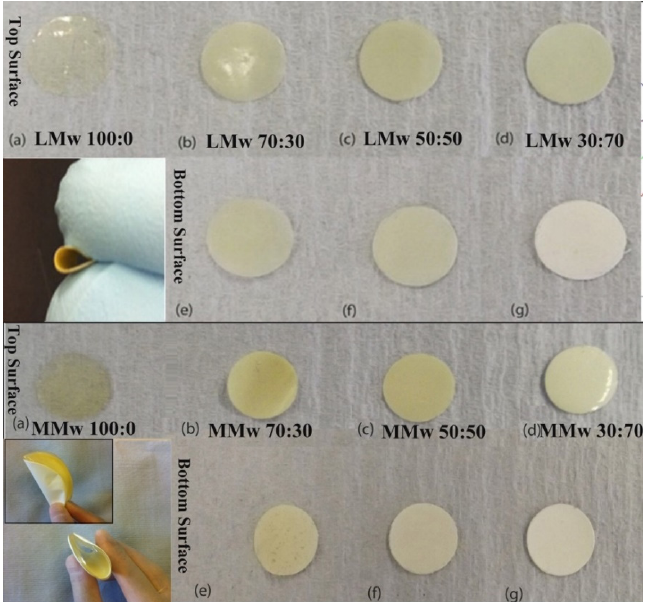
Figure 1. Optical images of LMw and MMwCH:HA membranes in different ratios of CH to HA with clear distinction between top and bottom surfaces of both molecular weight variants. Images taken with a DSLR S5600. The smaller inset image depicts the change in colour in between the top and bottom surface and their ability of the membranes to be bent, which is useful when using as a GTR in periodontal defect side. All ( a − d ) are top surfaces of LMw and MMw neat and composite membranes. All ( e − g ) are bottom surfaces of LMw and MMw composite membranes.